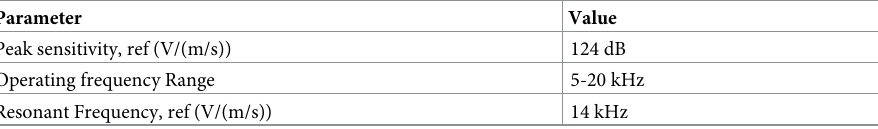
Table 2. Specifications of R1.5I-AST